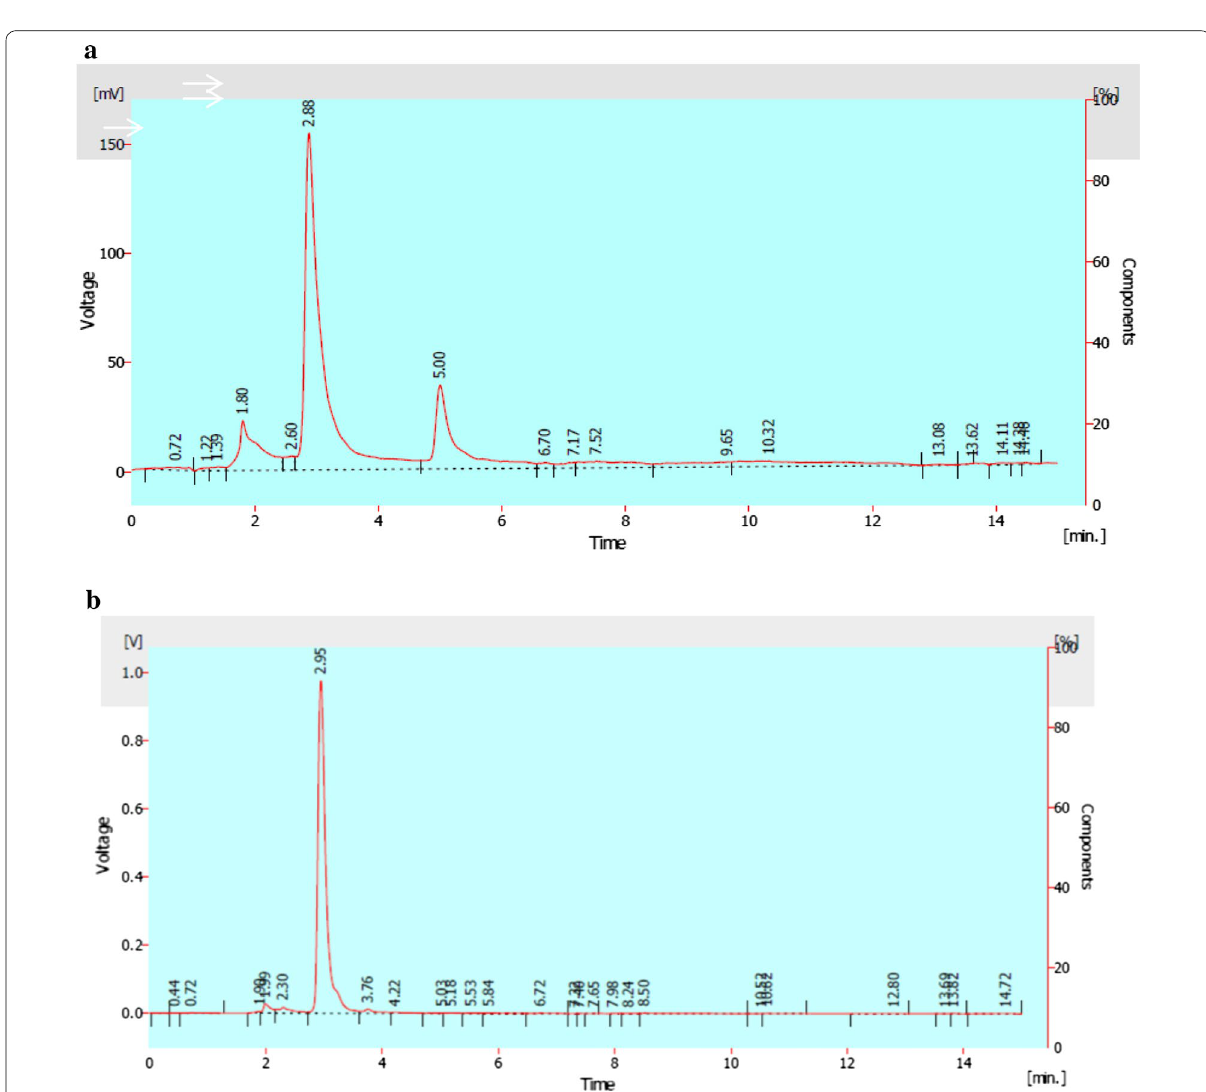
Fig. 4 HPLC analysis of reactive Synazol red 6HBN with a mobile phase of profile of methanol at 1.0 mL/min. The column was C-18 (250 a represents dye chromatogram while b represents A. aquatilis 3c degraded dye products extracted after 5 days of incubation at 37